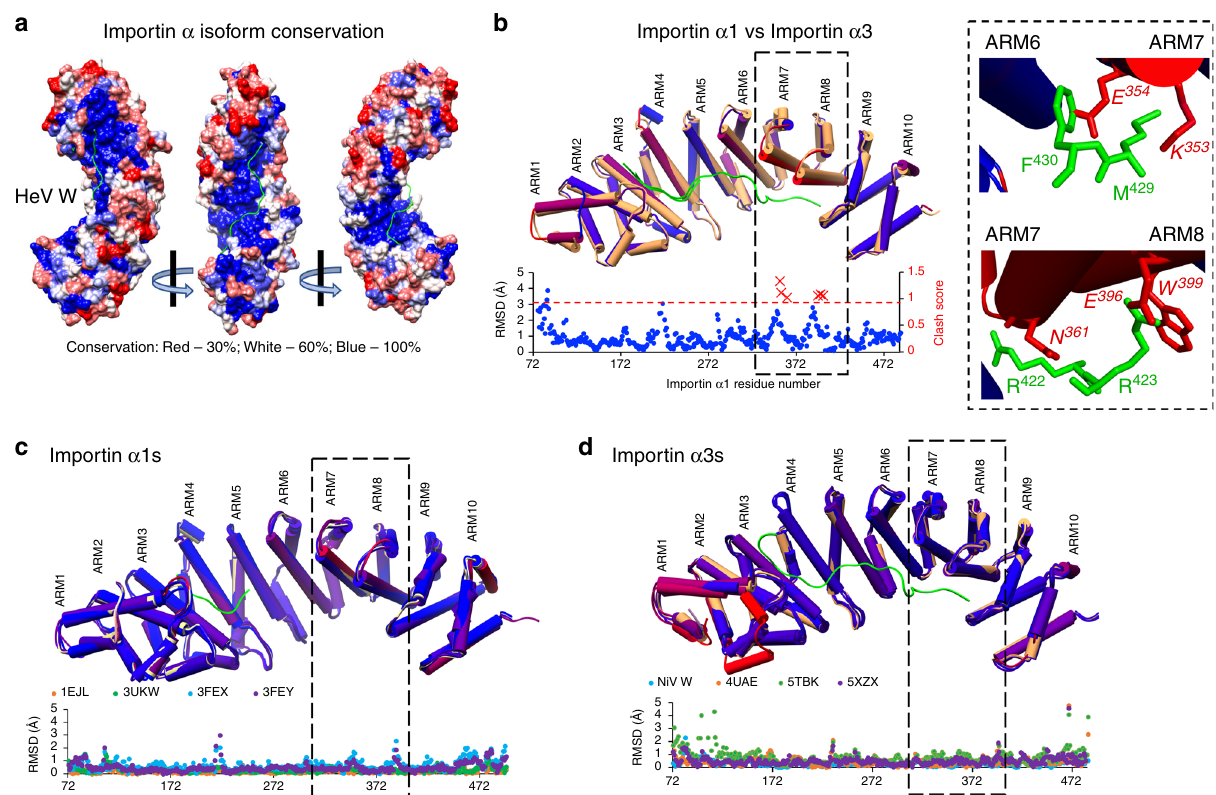
Fig. 5 Structural basis for speci fi city of Henipavirus W binding to the importin α 3. a Importin α 3:HeV W structure coloured by conservation of amino acids across all importin α isoforms highlights a 100% conservation in the binding interface. The HeV W NLS backbone (coloured green) is shown in complex with importin α 3, with sequence colour rendering red at 30%, white 60%, and blue 100% sequence identity. Figure created in UCSF Chimera using importin α alignments from Clustal Omega. b To identify structural differences, the structures of importin α 1:HeV W and importin α 3:HeV W were superimposed in UCSF Chimera using MatchEnsemble, and r.m.s.d. plots generated using MatchAlign, and MatchAssess functions. α -helices shown as cylinders; importin α 3 coloured orange throughout, and colour conservation rendering for importin α 1 set for blue, < 2.5 Å variance, and red for variances > 2.5 Å. Molprobity was used to analyse clash data of importin α 3:HeV W NLS superimposed to importin α 1, all clashes > 0.8 shown as red crosses. Differences in clash score between importin α 1 and α 3 are localised to ARMs 7 and 8. Detailed view of clashes are presented in the right box, highlighting residues clashing with the W NLS owing to the difference in positioning of ARMs 7 and 8 in importin α 1. All clashing residues are positioned on the α - helices of the ARMs. c Structural comparisons of importin α 1 bound to a range of cargo was examined by superimposing the α 1:HeV W NLS structure determined in this study (reference molecule, coloured yellow), with importin α 1 bound to a monopartite SV40T NLS 12 (1EJL), bipartite Bimax NLS 59,60 (3UKW), and two domain bound structures of CAP80 61 (3FEX, 3FEY) coloured according to r.m.s.d as described in b . Positioning of the α -helices in ARMs 7 and 8 are relatively static across all structures. d Structural comparisons of importin α 3 bound to a range of cargo was examined by superimposing the α 3:HeV W NLS structure determined in this study (reference molecule coloured orange) with the monopartite RanBP3 62 (5ZXZ), the NiV W (this study), and domains of PB2 19 (4UAE) and RCC1 15 (5TBK) coloured according to r.m.s.d as described in b . Positioning of α -helices in ARMs 7 and 8 are also relatively static across all